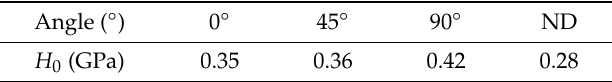
Table 2. Fitting values of H 0 under di ff erent